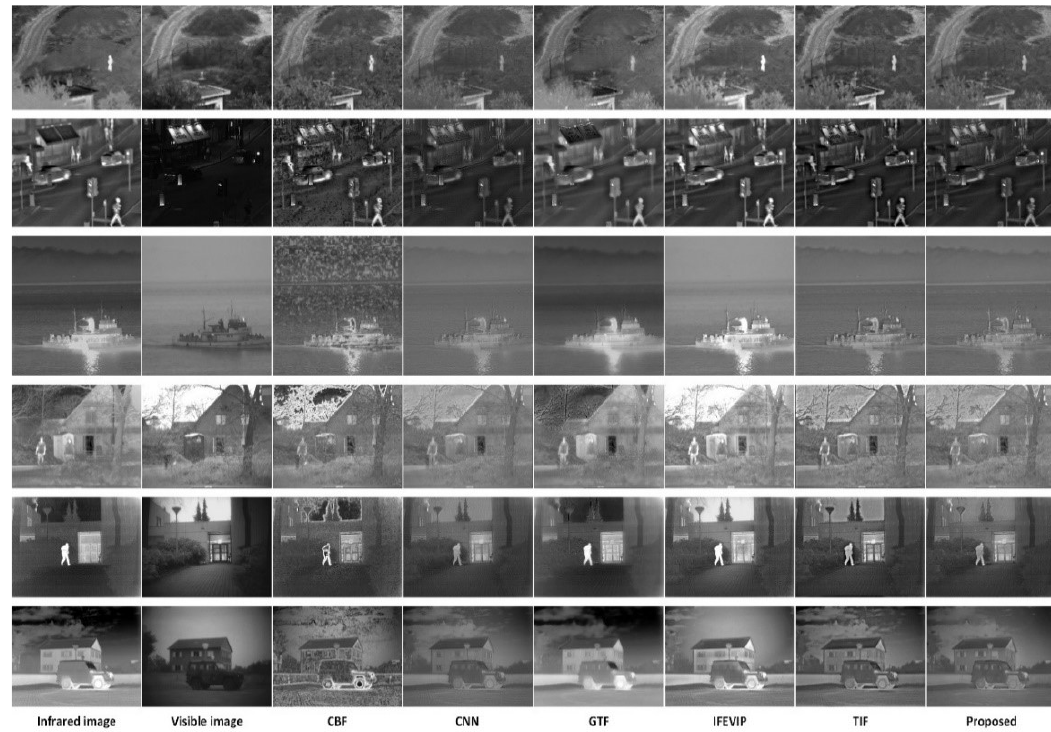
Figure 7. Fusion results of noise-free images.